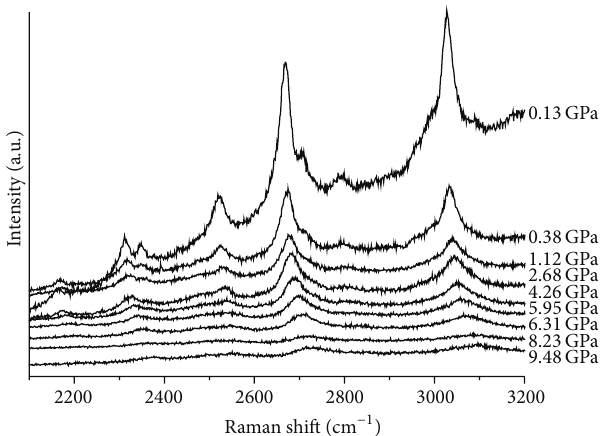
Figure 5: Raman spectra of canthaxanthin at different pressure in the spectral range 2100 − 3200 cm −1 .